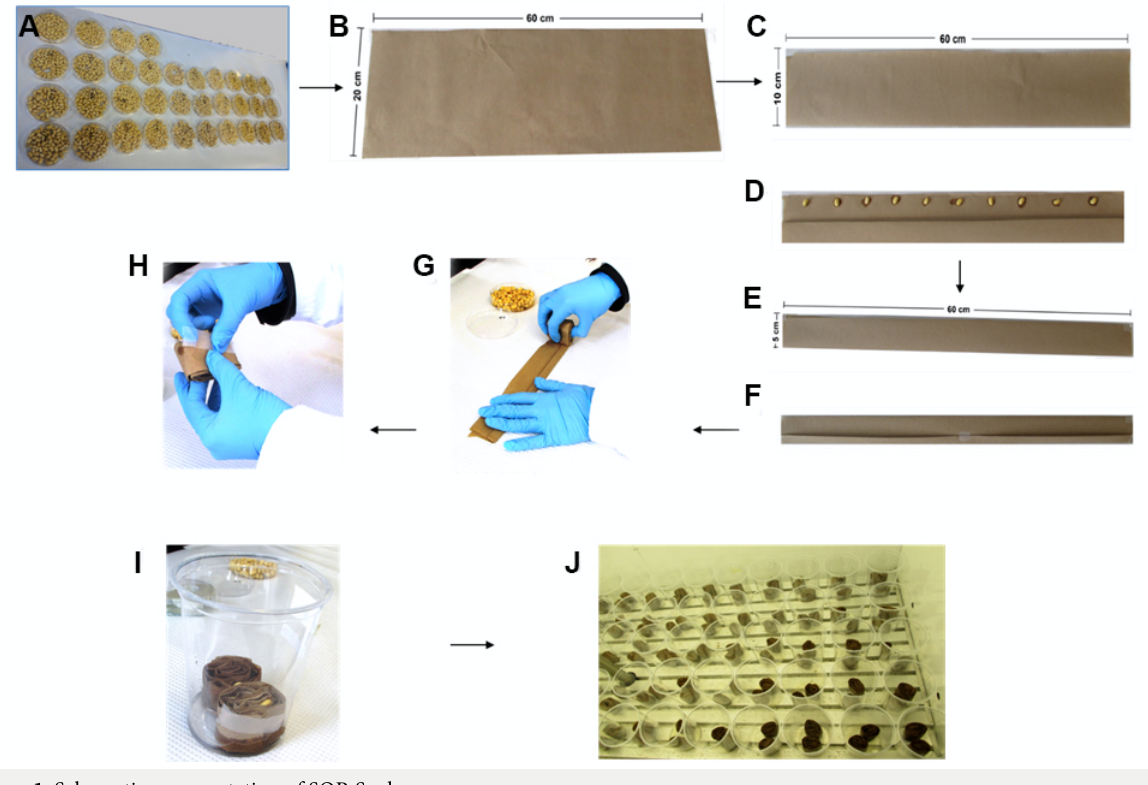
Figure 1 Schematic representation of